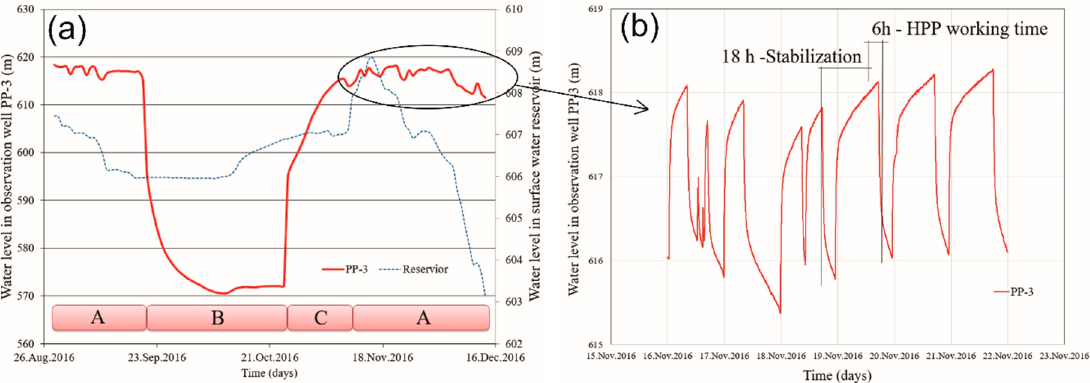
Figure 5. ( a ) Changes of groundwater level at PP-3 ( b ) Operating time—HPP work time and pressure stabilization .